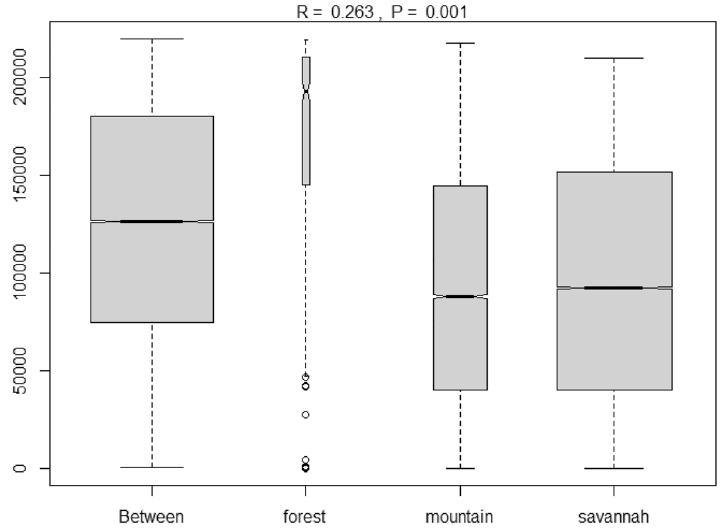
Figure 2. Rank order of dissimilarities between and within geographic regions of differentiation of the accessions of C. moschata of Cote d’Ivoire.